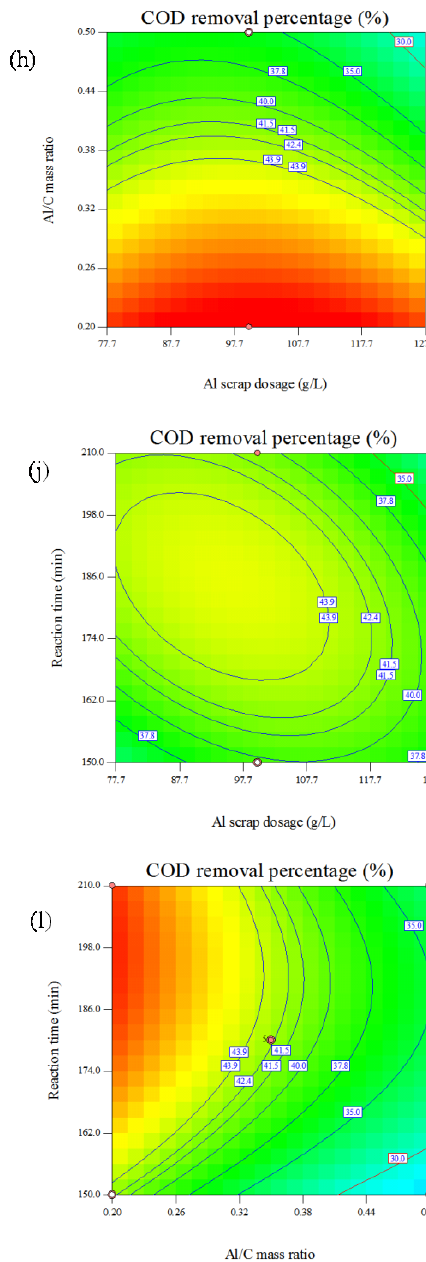
Figure 6. Response surface ( a , c , e , g , i and k ) and contour map ( b , d , f , h , j and l ) of COD removal